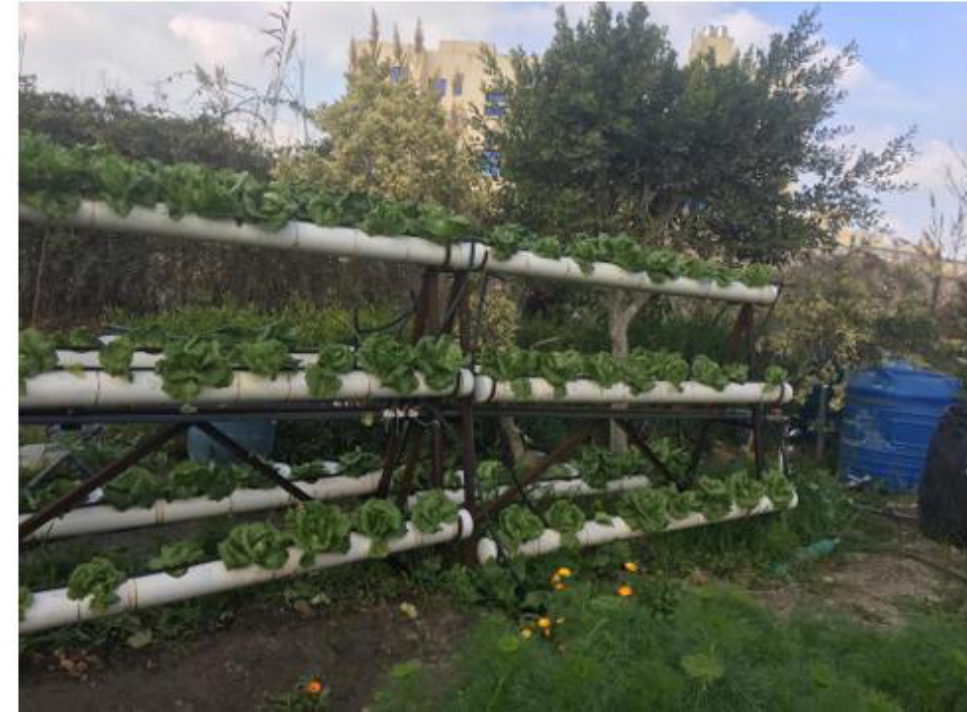
Figure A3. The experimental hydroponic farming system.